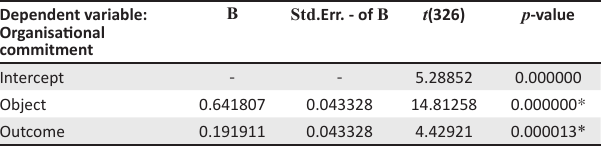
TABLE 7: The relationship between merger goal success, perceptions about merger outcomes and organisational